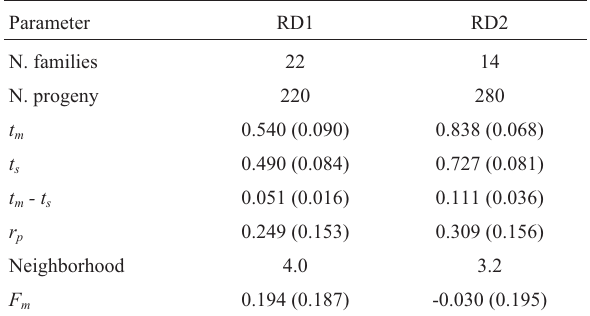
Table 1 - Mating system parameters in two populations of Senna multijuga . The parameters examined included the multilocus outcrossing rate ( t m ), mean single-locus outcrossing rate ( t s ,), biparental inbreeding rate( t m -t s ),correlationofpaternity( r p ),neighborhoodsizeandinbreeding coefficient of maternal parents ( F m ). Standard errors are shown in paren-